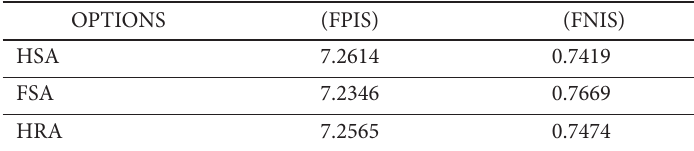
Table 8. Distance measurements